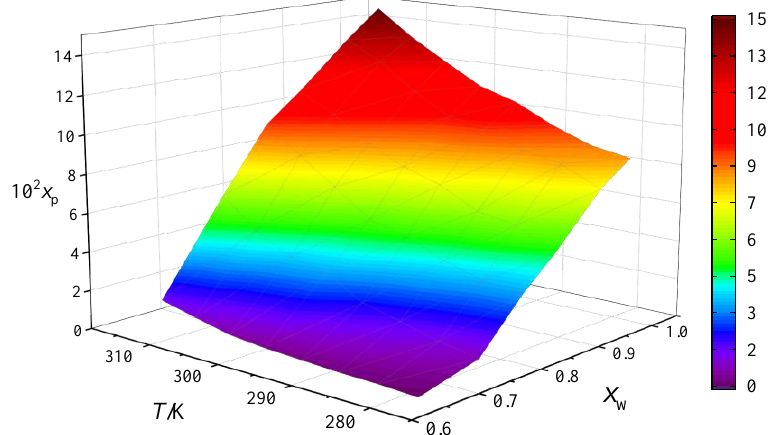
Figure 9. Mole fraction solubility of 1,5-pentanediamine adipate dihydrate in (water + DMF) mixed solvents with different mole fractions at various temperatures.